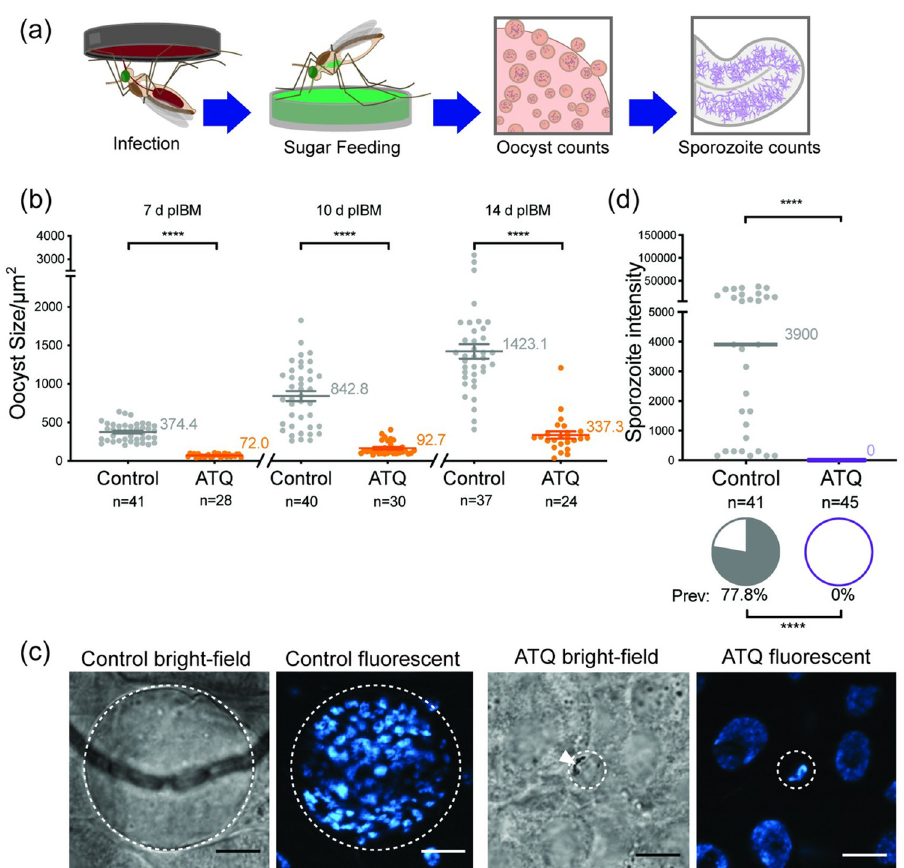
Fig 5. Ingestion of ATQ-glucose after P . falciparum (NF54) infection blocks parasite development in An . gambiae (G3). (a) Experimental scheme. (b) Oocyst size over time. Access to ATQ-glucose from 2 d pIBM caused a significant reduction in mean oocyst cross-sectional area (“size”/m 2 ) relative to control at 7 d pIBM (2-way T-test, n = 69, df = 67, t = 13.63, p < 0.0001), 10 d pIBM (2-way T-test, n = 70, df = 68, t = 8.998, p < 0.001), and 14 d pIBM (2-way T-test, n = 61, df = 59, t = 8.793, p < 0.0001). Means are indicated, error bars represent the standard error of the mean (SEM). (c) Example brightfield, and fluorescent micrographs of control and ATQ-exposed bright-field and DAPI-stained oocysts at 10 d pIBM (outline indicated by dashed line). At this timepoint, the control oocyst is large, and contains many discrete nuclear foci, indicating nuclear division and sporozoite differentiation. In contrast, the ATQ-exposed oocyst is small relative to control and contains a single nuclear focus. Dense hemozoin crystals (white triangle), typically associated with younger oocysts, are visible. Scale bars represent 10 μ m, (d) Salivary gland sporozoite prevalence and intensity at 14 d pIBM. No sporozoites (0% prevalence, median intensity = 0) were observed in salivary glands samples collected from mosquitoes given access to 100 μ M ATQ/0.5% DMSO/10% w/v glucose ad libitum (Chi 2 , n = 86, df = 1, Χ 2 = 53.202, p < 0.0001). Where relevant, median lines and values are indicated, “n” indicates the number of independent samples. To isolate Oocyst/Sporozoite Prevalence and Oocyst/Sporozoite Intensity, midgut samples with zero oocysts have been excluded from intensity analysis. Statistical significance is indicated where relevant as follows: ns = not significant, � = p < 0.05, �� = p < 0.01, ��� = p < 0.001, ���� = p <